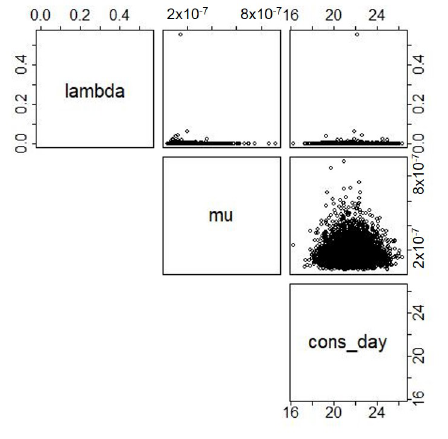
Figure A4. Scatterplots paired between input parameters for category